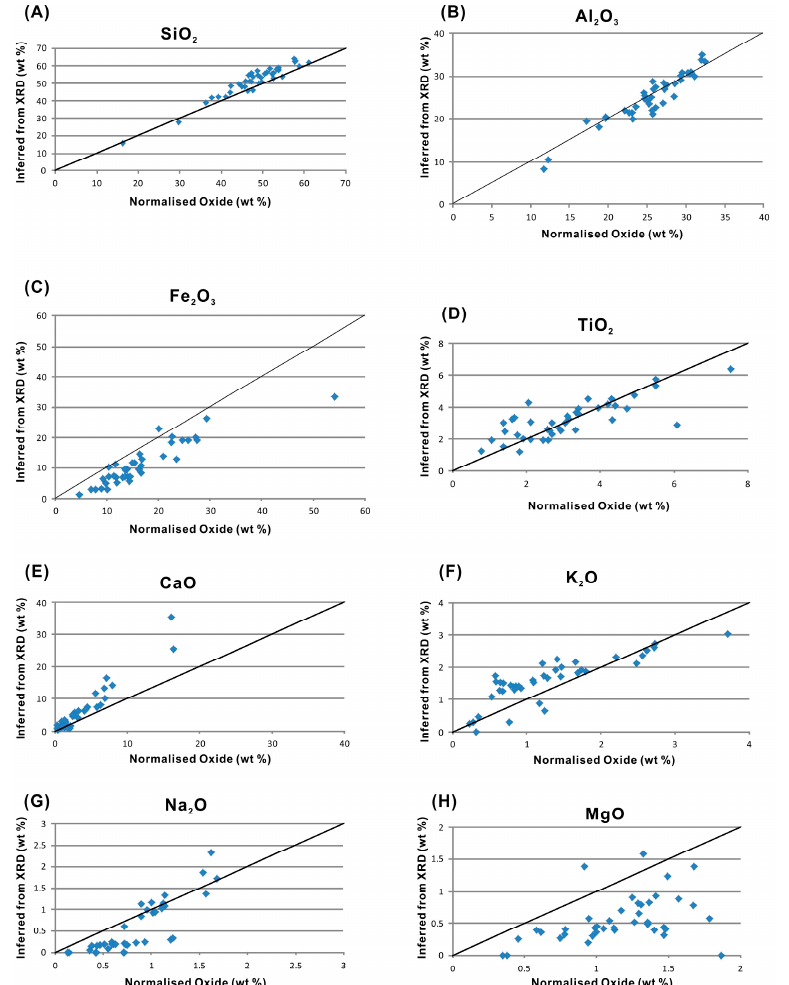
Figure 6. Comparison of observed oxide percentages from chemical analysis ( x -axis) to oxide percentages inferred from XRD data ( y -axis) in the Zhongliangshan coal and non-coal samples. The diagonal line in each plot indicates equality.